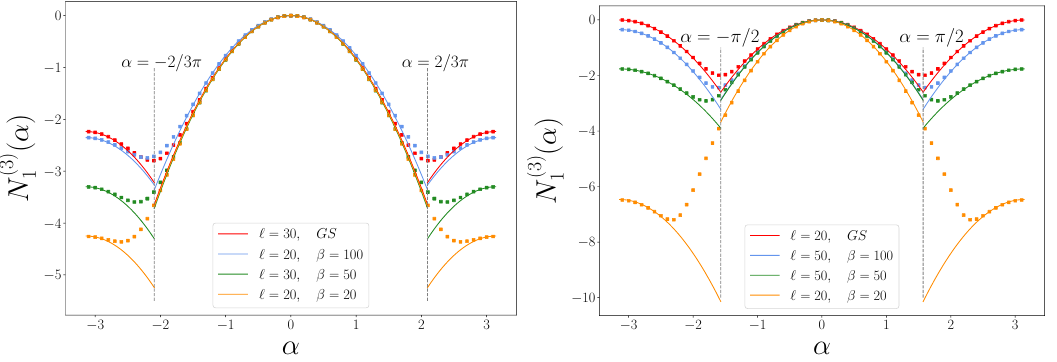
( 3 ) ( α ) for tripartite (left) and bipartite (right) Figure 3: The charged probability N 1 geometry as a function of α . We set L = 100. Analytical predictions in Eqs. (87) and (119) are compared with the exact lattice computations at different β . Notice the discontinuities at α = ± 2 / 3 π (left) and α = ± π/ 2 (right).